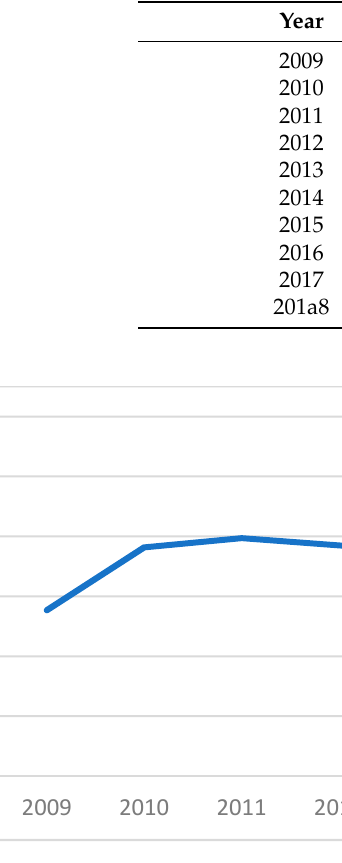
Figure 1. Global Moran index from 2009 to 2018.